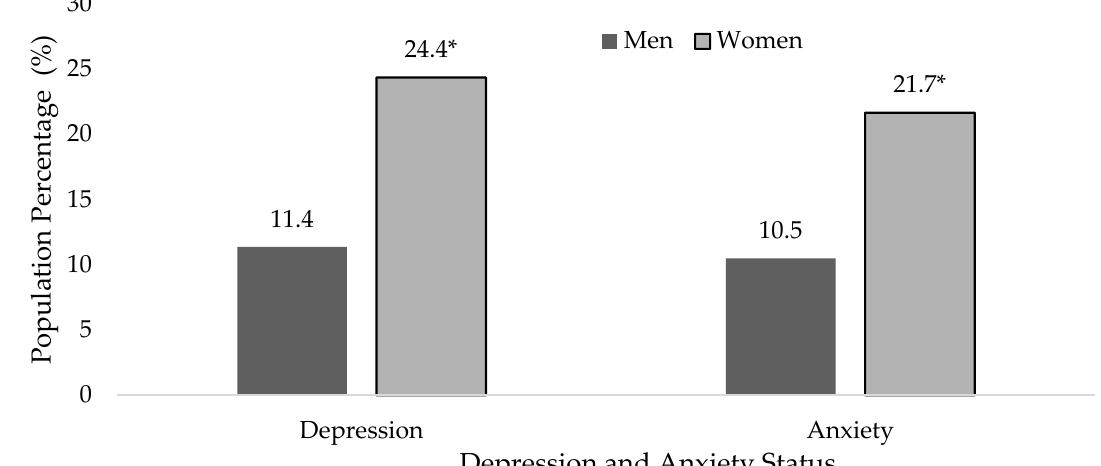
Figure 2. Depression and Anxiety status by sex in Spanish people with Hypertension (* p < 0.05 from z-test), according to the ENSE2017.